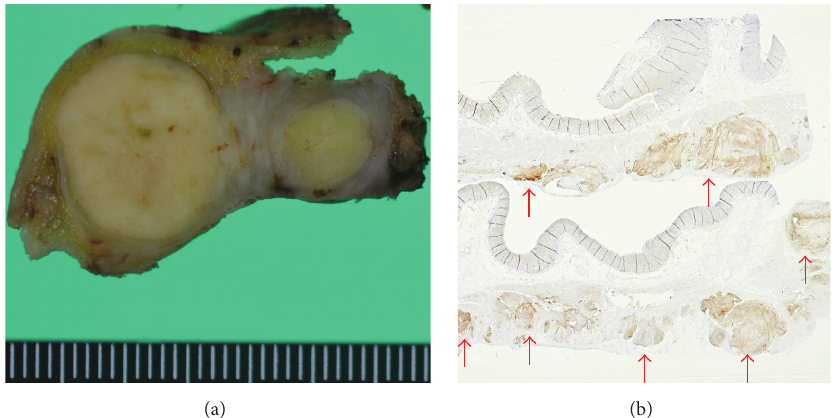
Figure3:(a)SMTofthemiddlegastricwallcontainedtwointramurallesions(1.4 × 1.2 cmand0.8 × 0.6 cm).Therewerenofindingsindicating tumor rupture in these two lesions. (b) Multiple nodules located in subserosa of upper stomach. These nodules were positive for KIT (CD117).